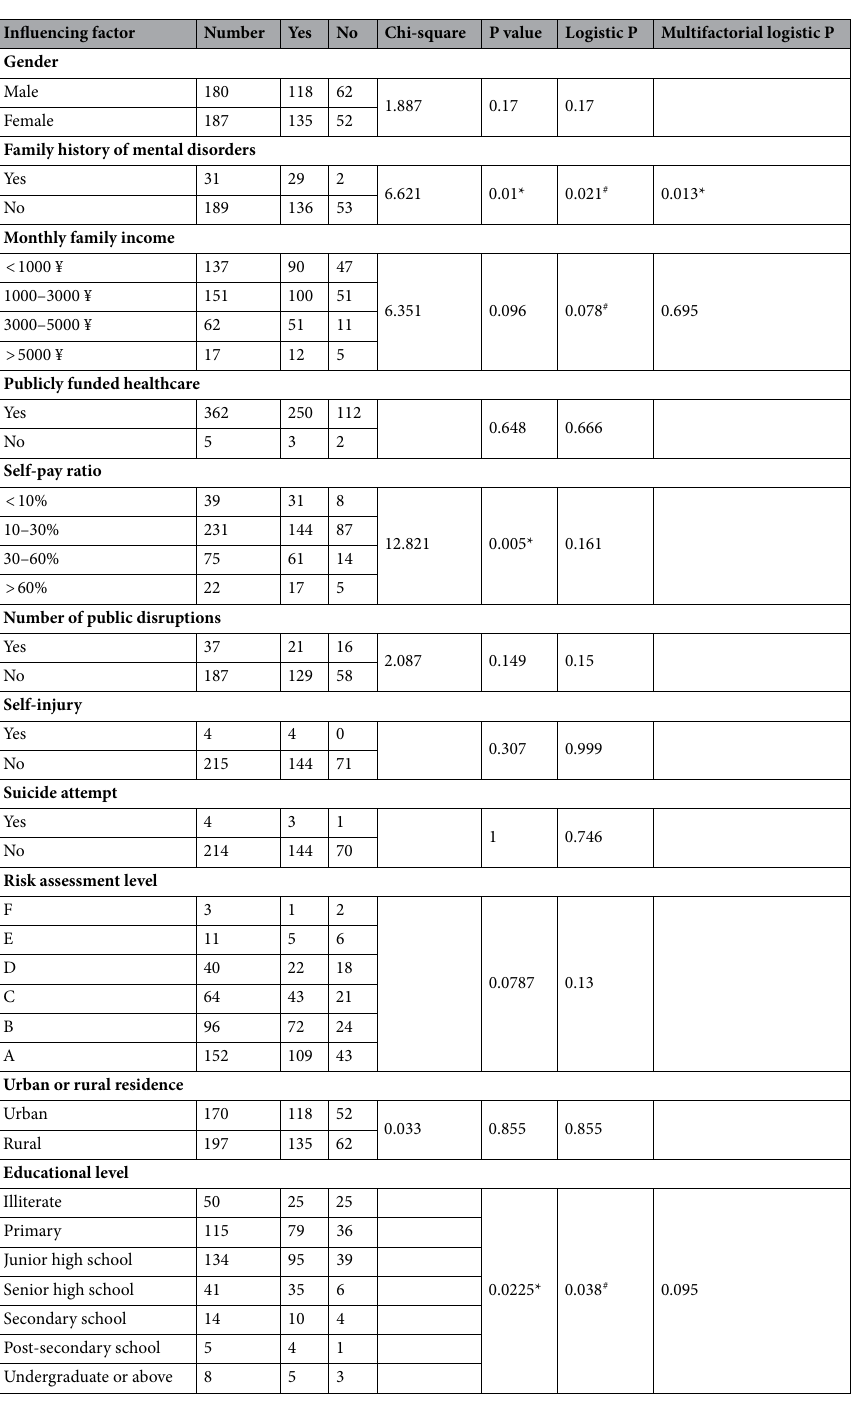
Table 1. Comparison in help-seeking versus non-help-seeking behavior based on influencing factors. # P < 0.1, *P < 0.05. F Violence against others, arson, explosion, etc., E Repeated smashing behavior, regardless of the occasion, against property or people and cannot be persuaded to stop (including suicide), D Smashing behavior, regardless of the occasion, against property and cannot be persuaded to stop, C Smashing behavior against property, confined to the home, and can be persuaded to stop, B Verbal threats and shouting without hitting, A None of the above